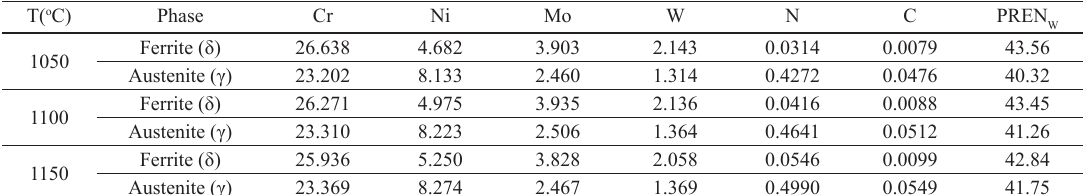
values of each phase obtained by simulation ( Thermo-Calc ® ). W